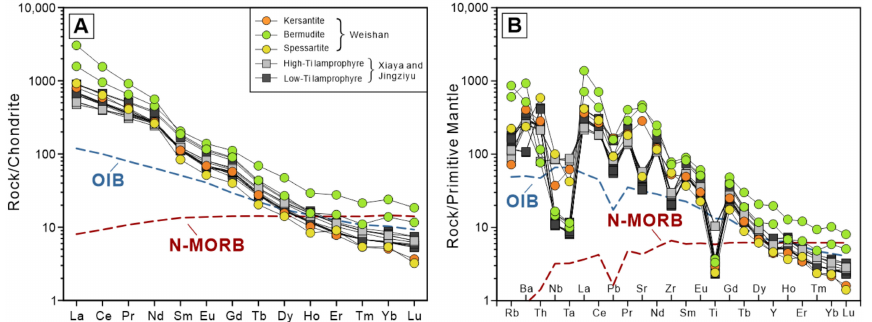
Figure 7. ( A ) Chondrite-normalized REE patterns for lamprophyres. ( B ) Primitive mantle-normalized trace element patterns for lamprophyres. Data sources: chondrite [37], primitive mantle [38], N- MORB and OIB [39].